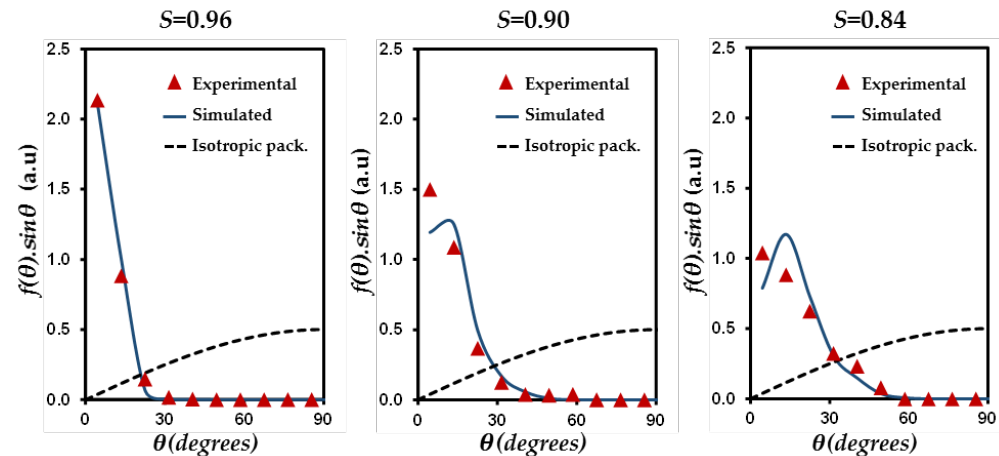
Figure 4. Comparison between simulated and experimental distributions of particle orientation f ( θ ) sin θ with θ the angle between the normal unit vector of the particle and the z axis of the simulation box. The selected experimental packings correspond to DP1, DP4, and DP5 (with S = 0.96, 0.90, and 0.84, respectively, Table 1), whereas simulated packings were chosen in Table 2 for their similar S values (with S = 0.96, 0.89, and 0.84).